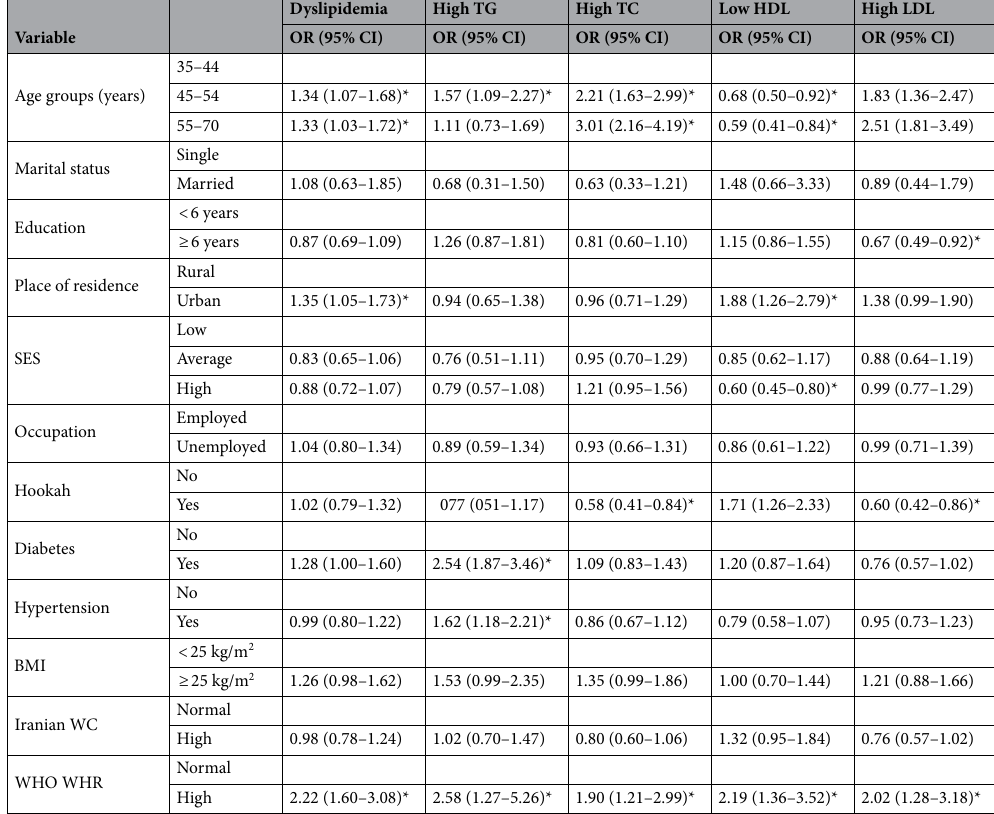
Table 3. Logistic regression analysis of dyslipidemia and individual lipid abnormalities. OR, odds ratio; CI, confidence interval; TG, triglyceride; TC, total cholesterol; HDL, high-density lipoprotein; LDL, low-density lipoprotein; SES, socioeconomic status; BMI, body mass index; WHO, World Health Organization; WC, waist circumference; WHR, waist-to-hip ratio. *Statistically significant ( P -value <